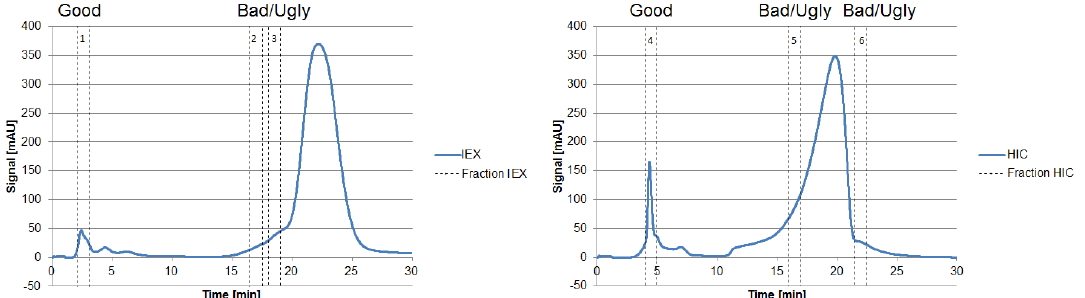
Figure 7. Chromatograms of an analytical IEX ( left ) and HIC ( right ) measurement of the diafiltrated cell-free CHO supernatant. The vertical sections represent the number of fractions taken, representing “Good”, “Bad,” and “Ugly” impurities.